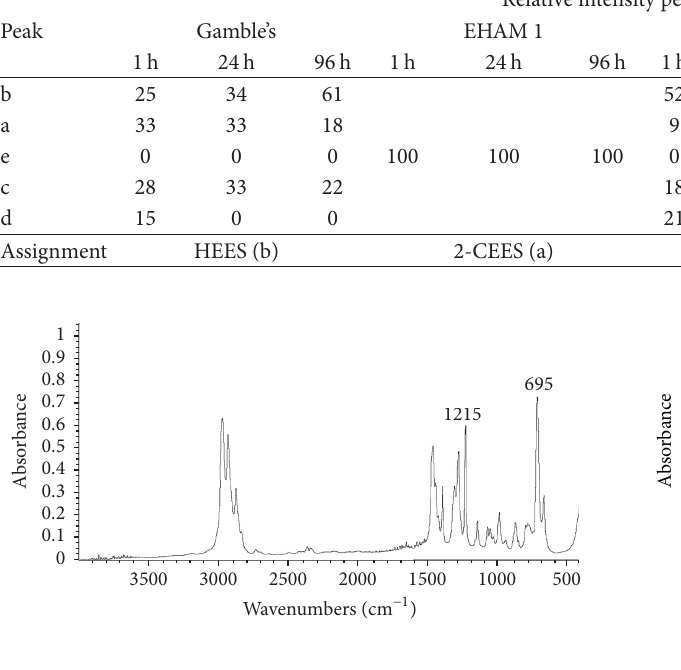
F 3: FTIR spectrum of 2-CEES. F 4: Subtracted FTIR spectra of EHAM 1 and